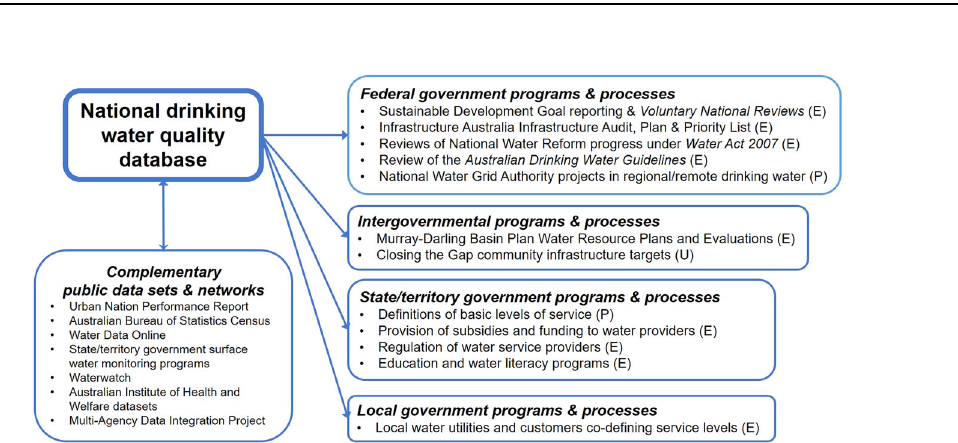
Fig. 6 Information fl ows from a national drinking water quality database to government water programs and processes in Australia. (E) Existing programs and processes, (P) Proposed programs and processes, (U) Under development programs and